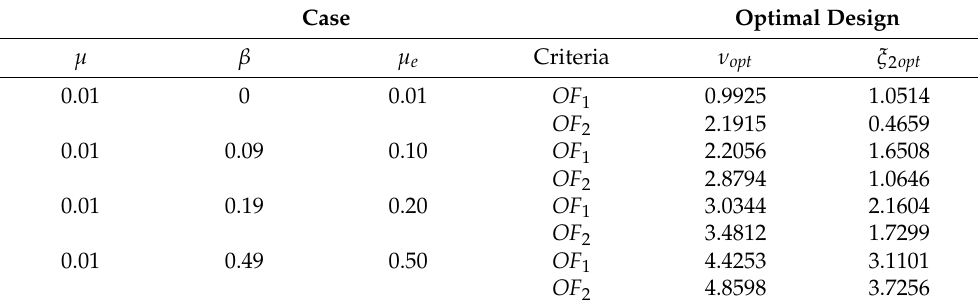
Table 1. Optimal parameters for various values of parameter β